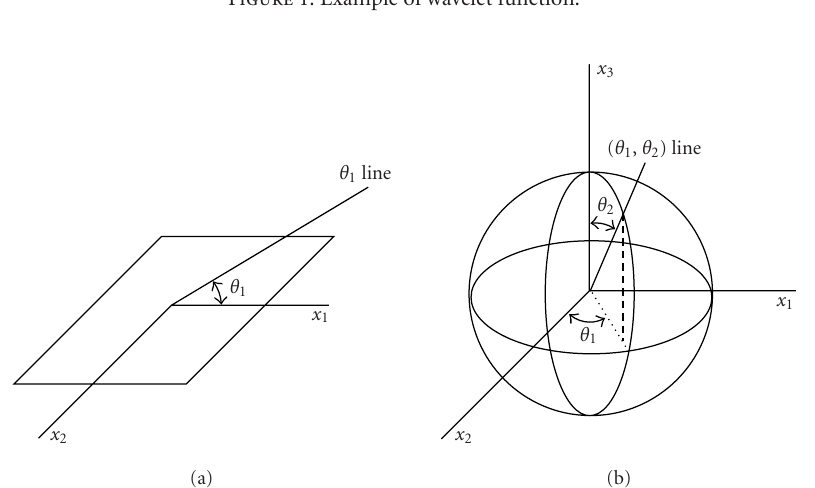
Figure 1: Example of wavelet function.